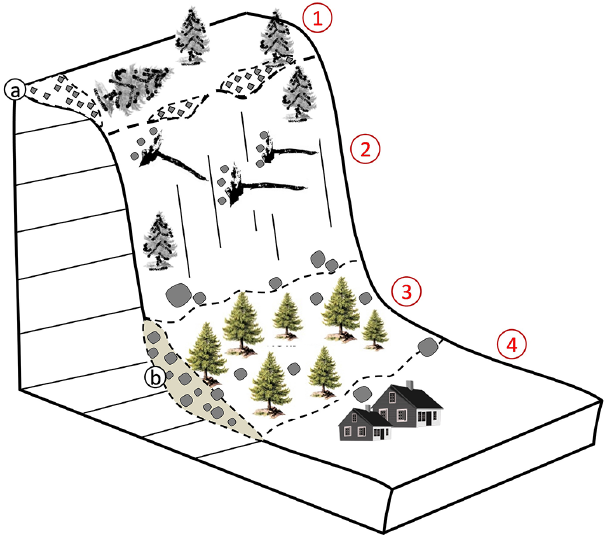
Figure 4. Sketch of the wildfire affected area. During the wildfire, the trees in the less inclined upper rock wall (1) and in the verti- cal rock wall (2) show indicators for medium fire severity; the pro- tection forest (3) did not get affected by the wildfire. During the fire, rockfalls were detached from the rock face and by falling trees, which reached the houses in the valley floor (4). Scree is depicted in (a) . Talus is depicted in (b)